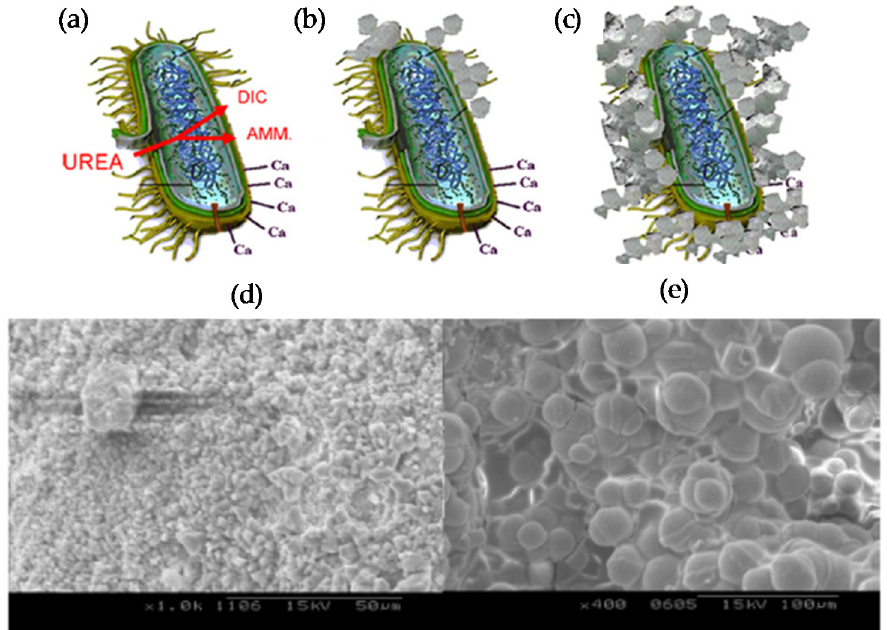
Figure 11 . ( a – c ) Simplified mechanism of bacterially induced carbonate precipitation [73] and SEM micrographs ( d ) before and ( e ) after the precipitation [72]. AMM, ammonia; DIC, carbon dioxide.